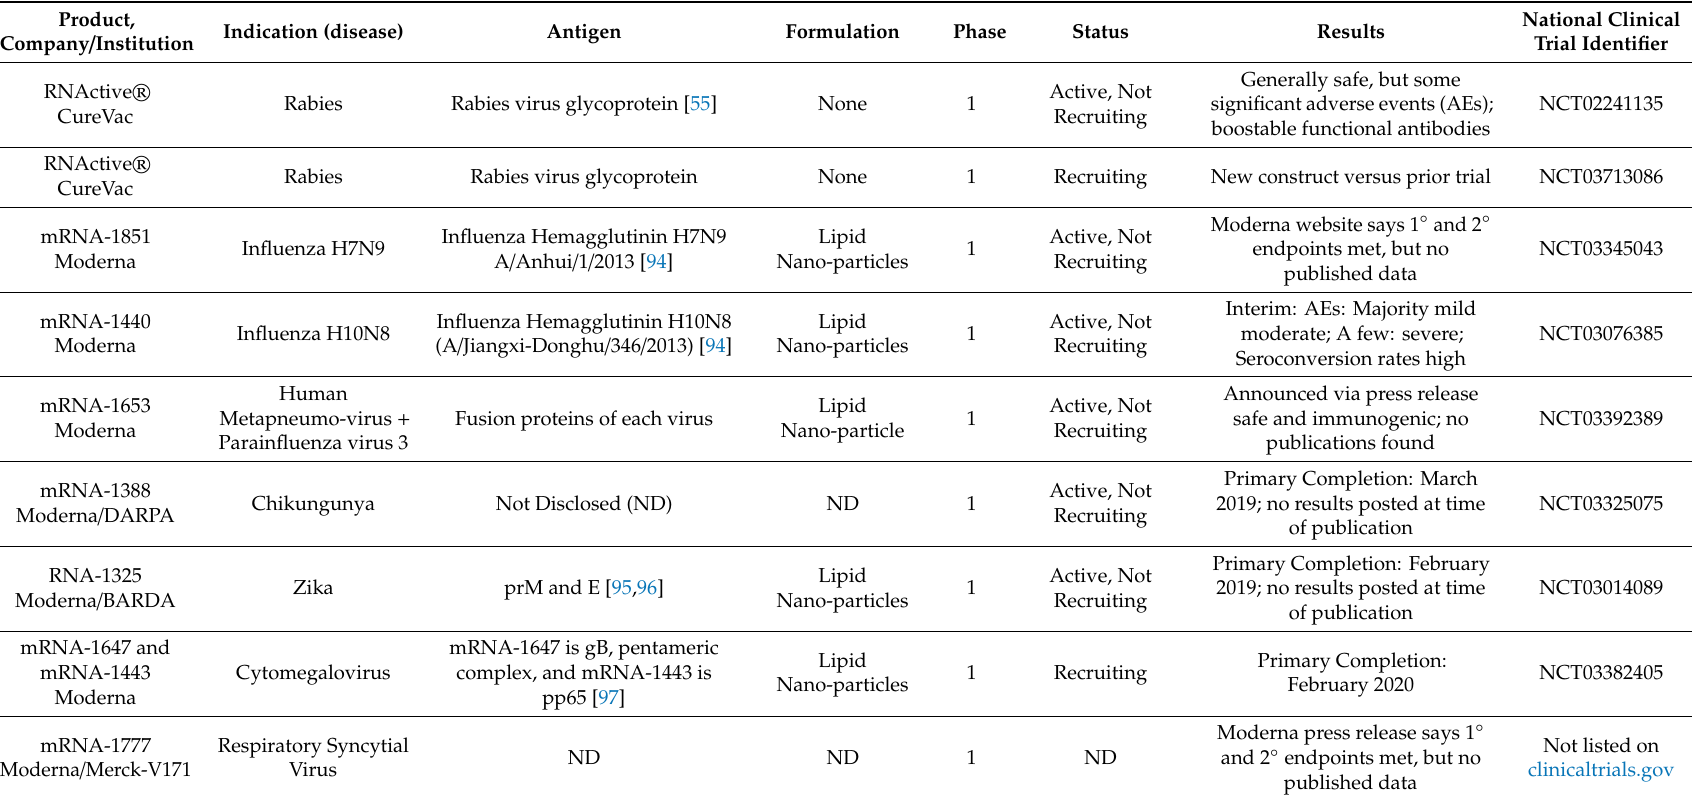
Table 3. Clinical trials for mRNA prophylactic vaccines for infectious